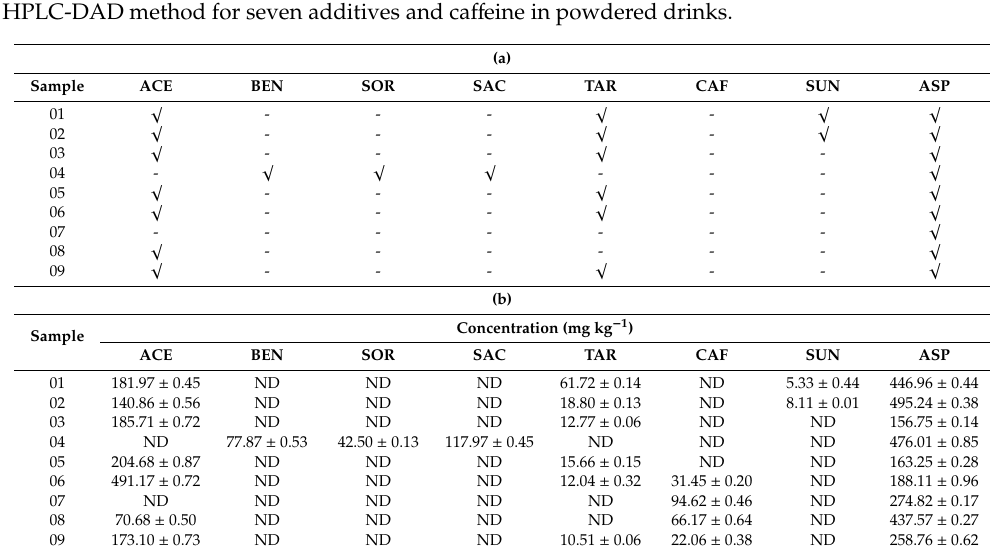
Note: acesulfamepotassium(ACE),benzoateacid(BEN),sorbicacid(SOR),sodiumsaccharin(SAC),tartrazine(TAR), ca ff eine (CAF), sunset yellow FCF (SUN), and aspartame (ASP).“-” Not listed on the label as an ingredient, “ on the label as an ingredient, “ND” Not detected. The values are mean ± standard deviation of experiments performed in duplicate. National and international regulations are applied to control the use of food additives in powdered drinks. In Indonesia, the actual regulation is referred to as the National Agency of Drug and Food Control (NADFC) guidance. The established guidance rules for the studied additives in powdered drink products are as follows: ACE, max. 600 mg kg